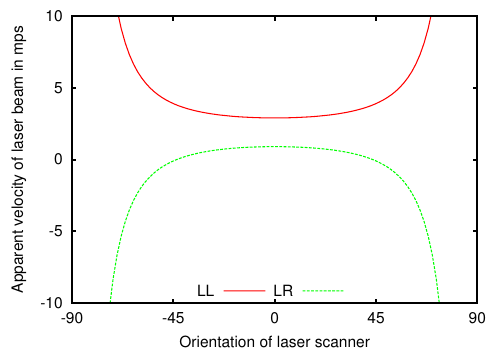
Figure 5: The velocity of the laser beam on surfaces parallel to the motion of the platform and at a distance of 1 m. The platform moves at a speed of 1m/s, whereas the laser scanner requires 6 s for a single rotation in a clockwise fashion